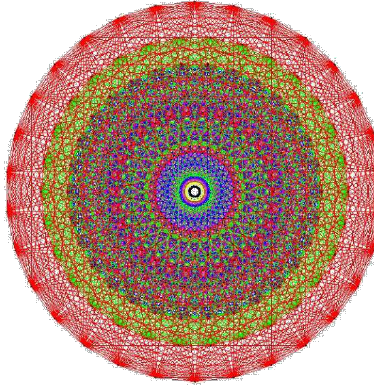
Figure 1. An 8-dimensional lattice in 2D